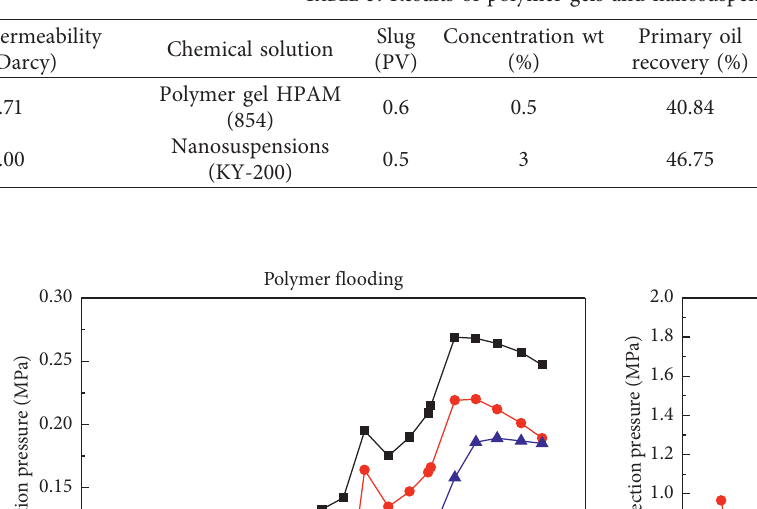
Figure 3: First water flooding pressure curves before the placement of polymer gel and nanosuspensions. Table 3: Results of polymer gels and nanosuspensions injections.